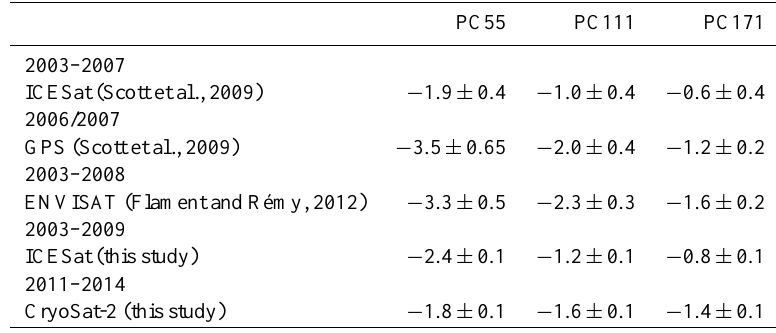
Table 3. Elevation change (myr − 1 ) at GPS points from Scott et al. (2009) at Pine Island